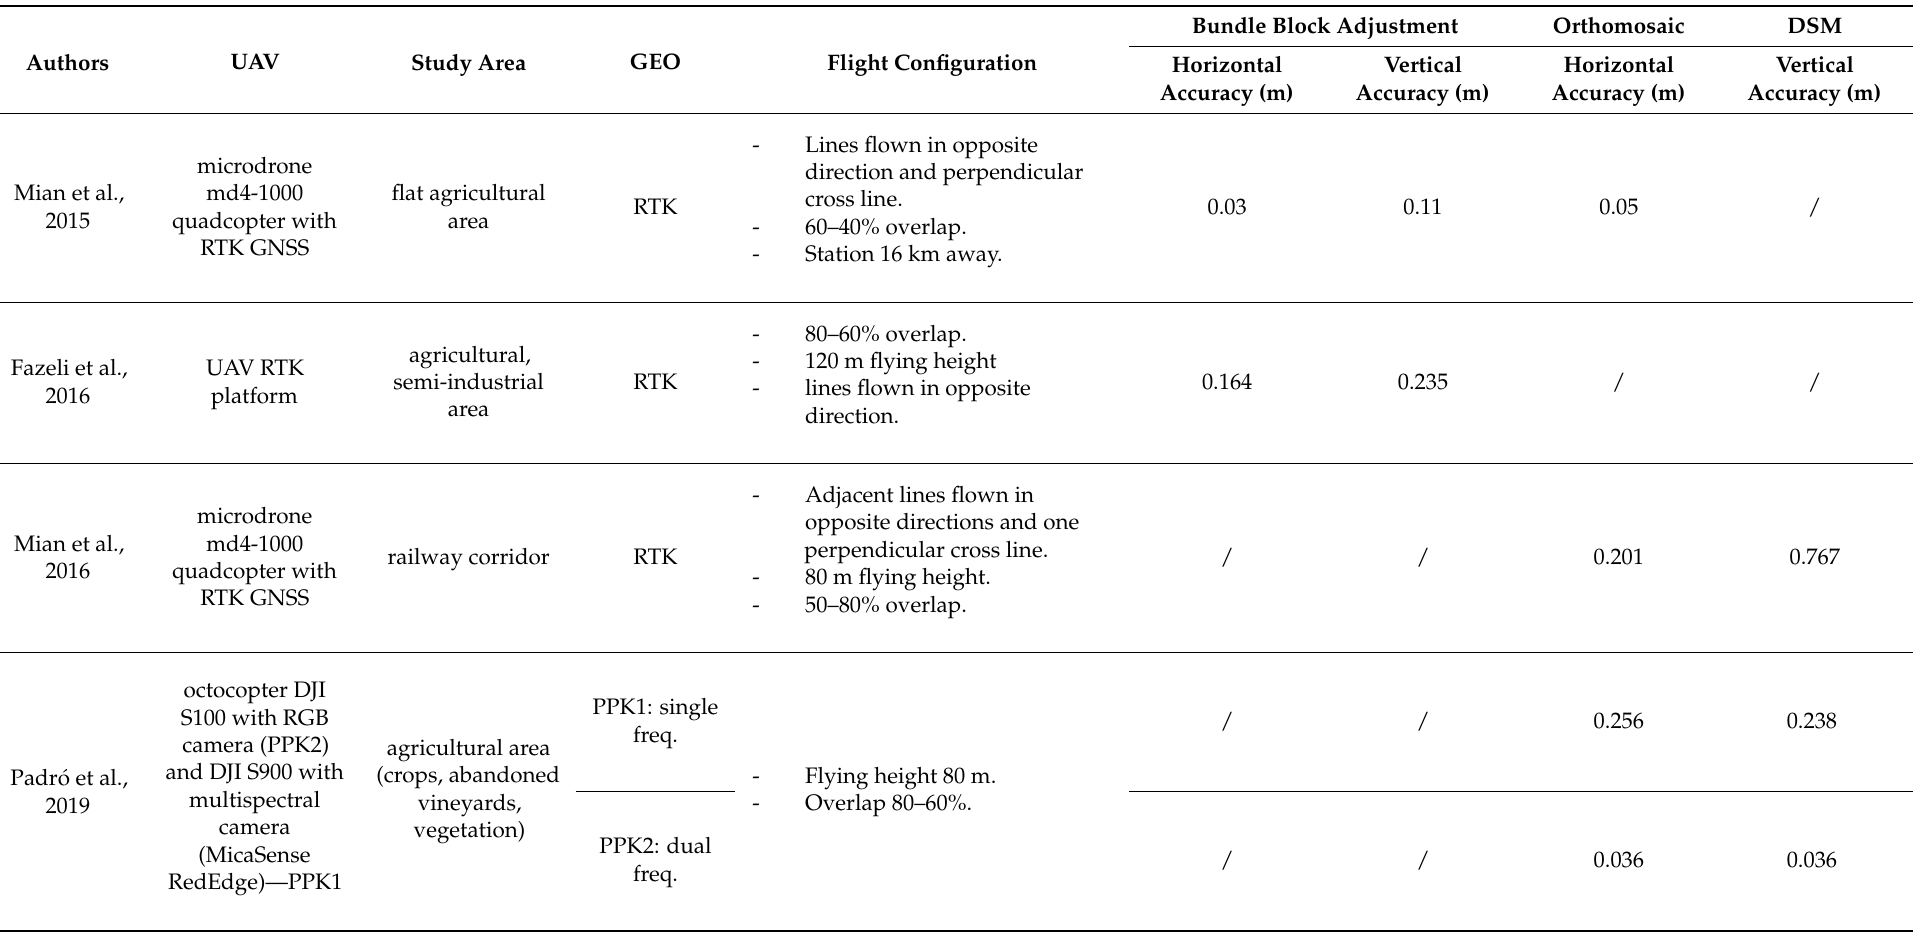
Table A1. The review of studies that included georeferencing without the use of GCP points (RTK, PPK, and NRTK) in their work. Sign “/” is indicating that information is not available. Authors GEO Flight Configuration